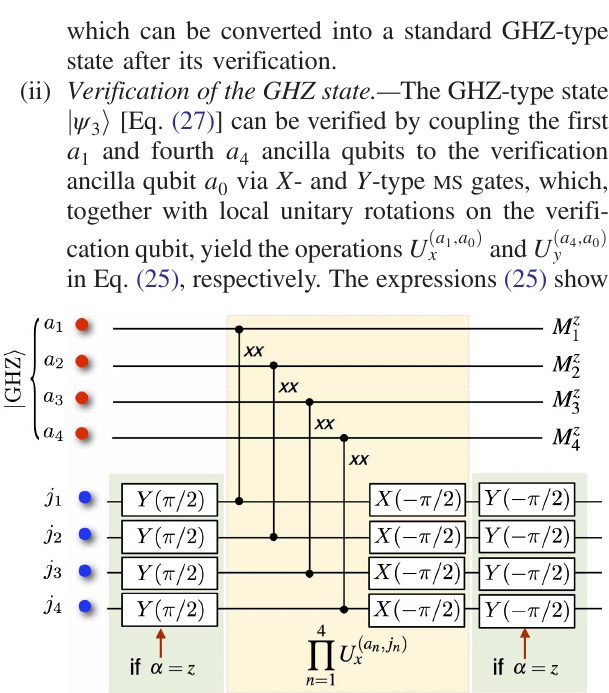
FIG. 9. MS-based circuit for transversal coupling in the DiVincenzo-Shor scheme: The stabilizer S ð n Þ α ffiffiffi p 2 x x x ð 1 = Þðj x i (cid:3) j x − x − x − x − iÞ by a sequence of two-ion þ þ þ þ MS gates and local rotations (25). This relative phase is revealed ancilla